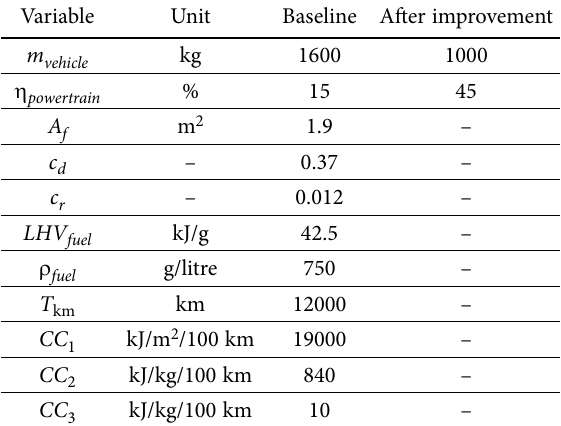
Table 1. Assumed baseline vehicle characteristics,